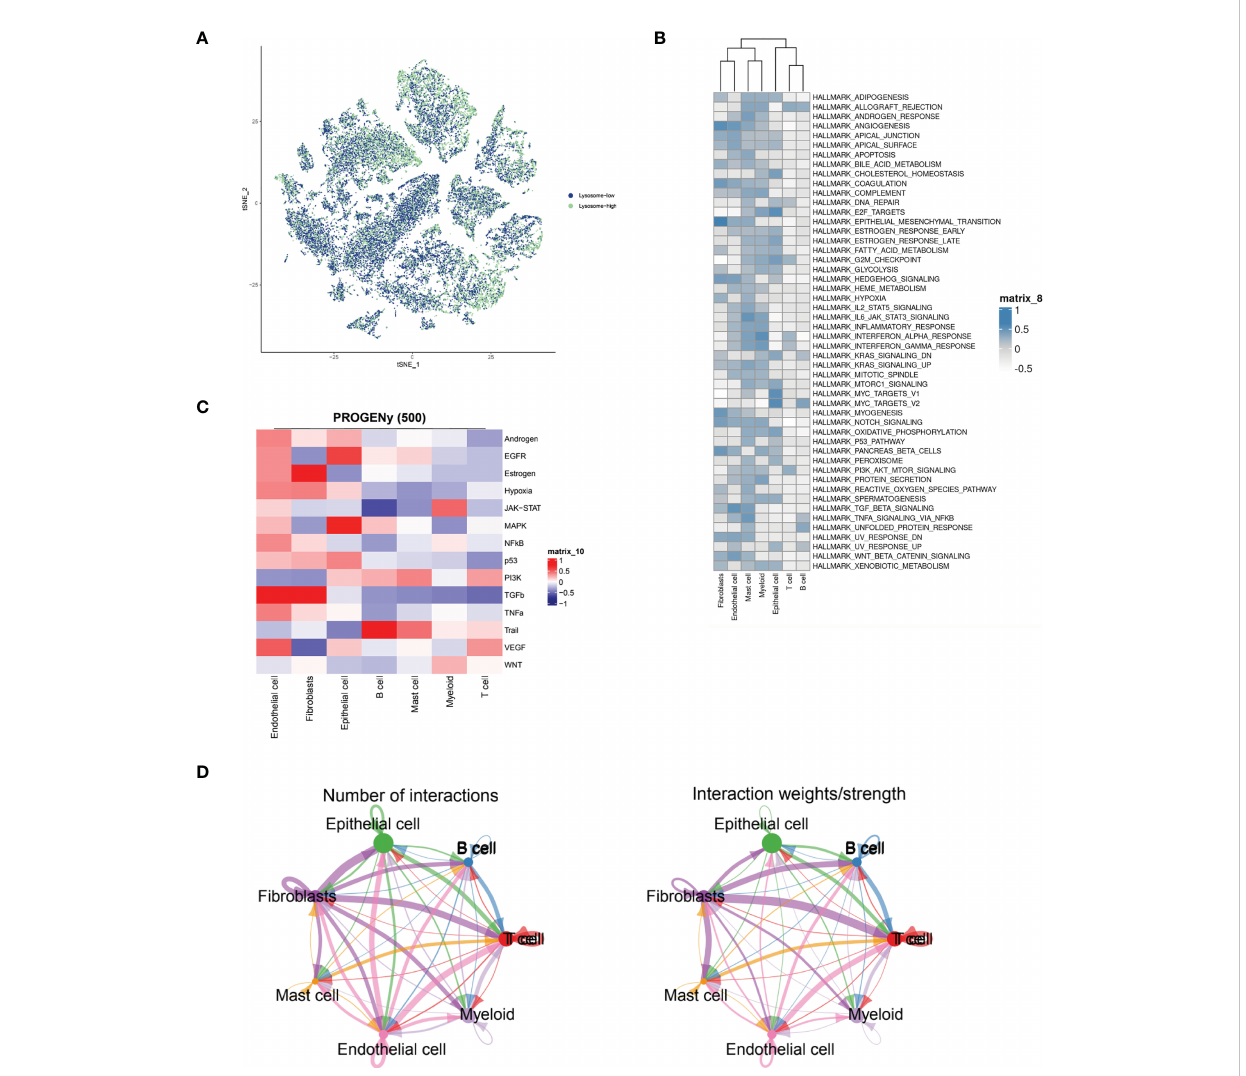
FIGURE 2 ESCC immune cell types interacting with lysosomal pathway and GSVA enrichment analysis. (A) t-SNE plots showing the expression of lysosomal pathway-related genes in seven major cell types in ESCC cells, divided into two groups, lysosome-high and lysosome-low, based on colour; (B) GSVA enrichment pathway scores were calculated for the Lysosome-high and Lysosome-low groups using 50 Hallmark data sets; (C) Calculation of PROGENy scores will obtain heat maps showing the scores of tumour-associated pathways for different cell populations; (D) Circle interaction plots showing the number and weight analysis of ineraction of Fibroblasts cells with the remaining several immune